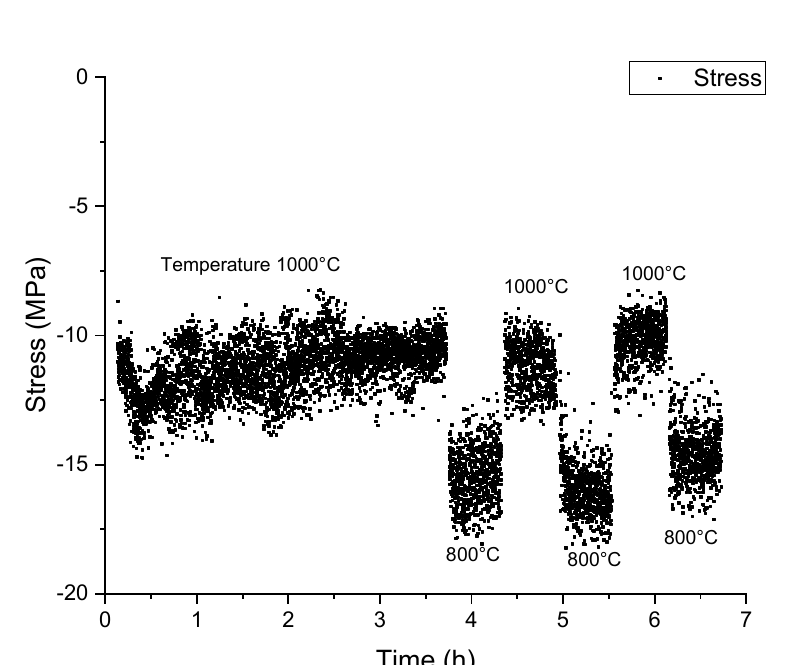
Figure 12. Stress evolution in the metal versus time for R0.58. The uncertainty for each plateau is around 5 MPa.